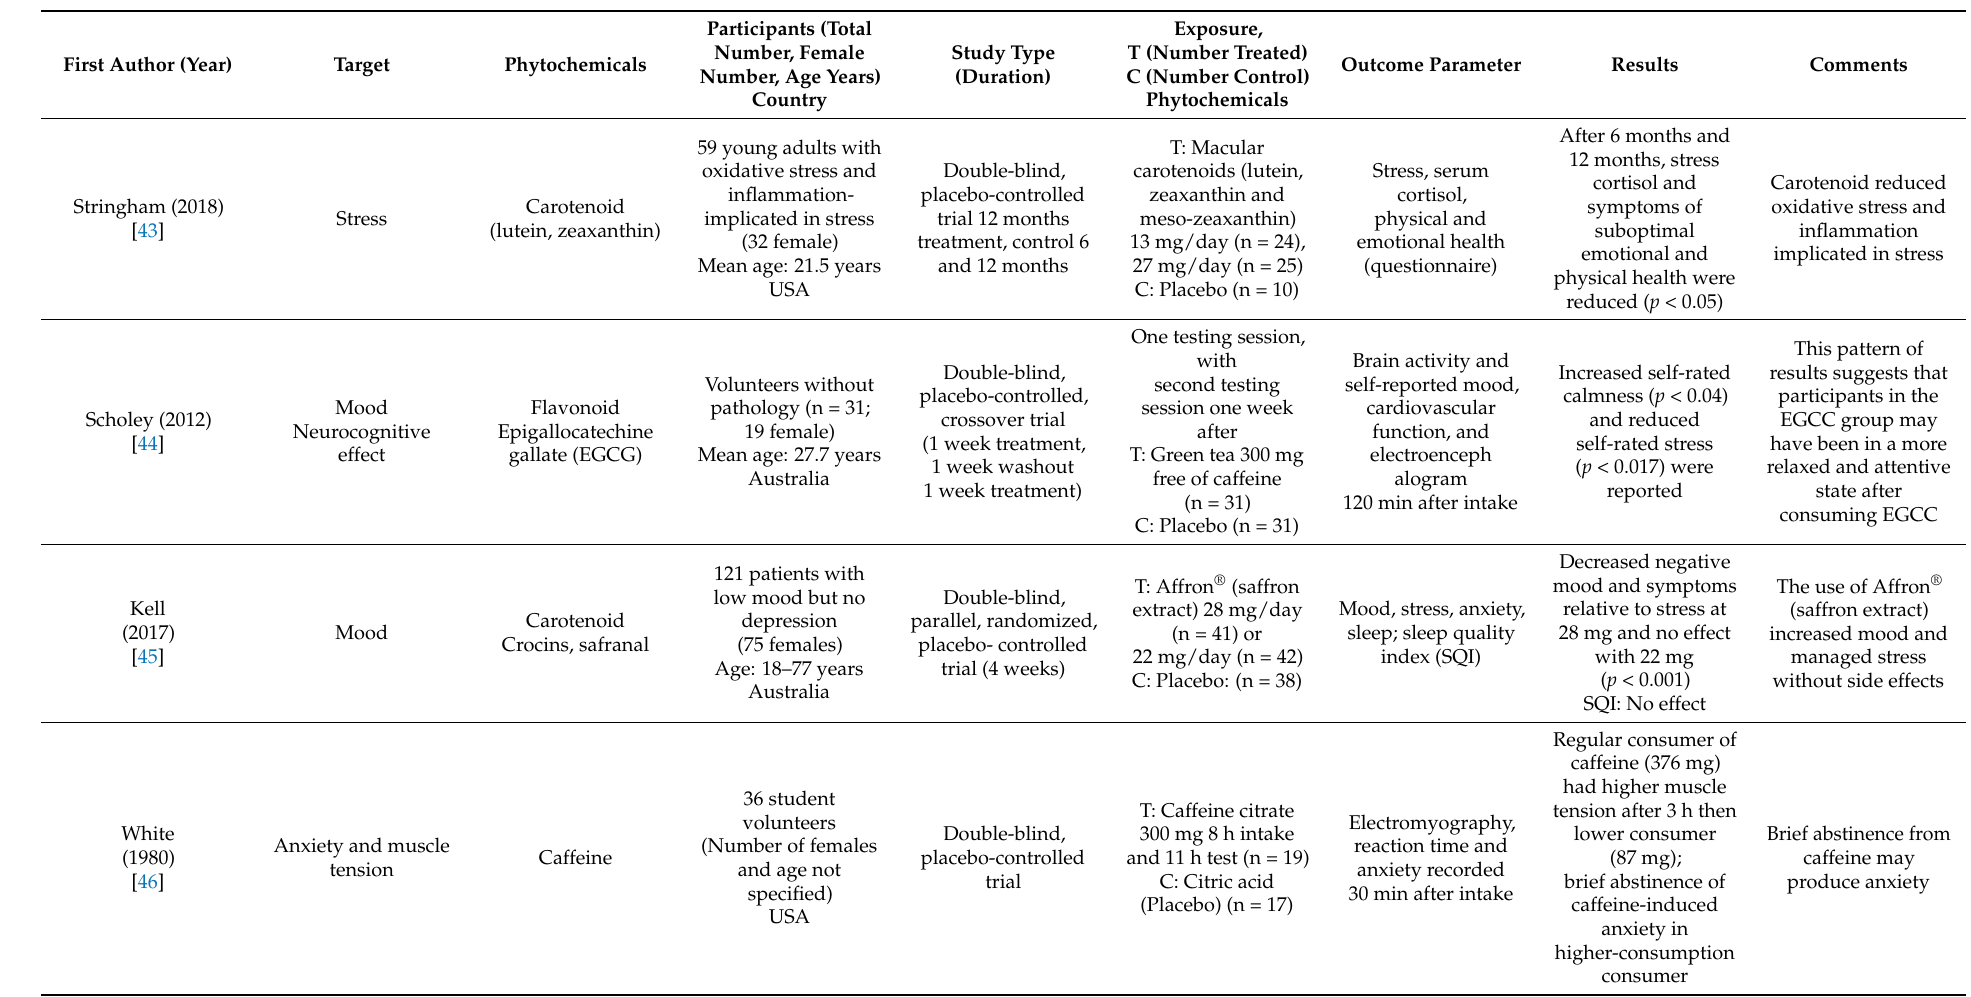
Table 3. Summary of selected studies regarding the therapeutic area of stress and sleep